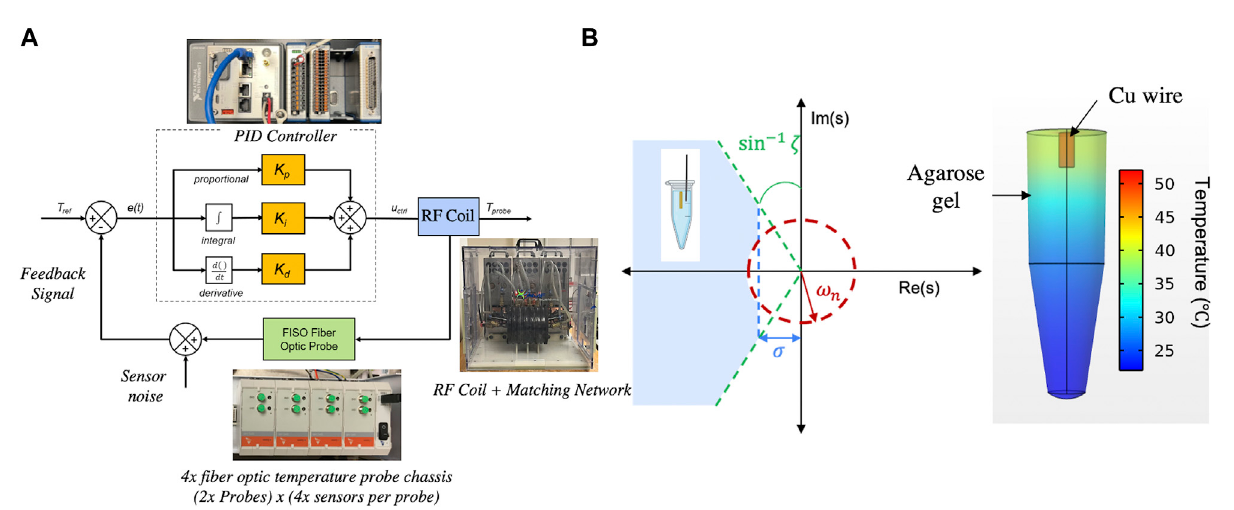
FIGURE 1 (A) Schematic block diagram of the PID controller depicting the error signal ( e(t) ) input and control signal ( u ctrl ) generation to minimize the error e(t) using the PID algorithm. Adapted Jangam et al. (2022), with permission from SB3C Foundation, Inc. Reproduced under CC-BY-4.0, Sharma et al (2023). (B) Regionsinthe s -plane,delineatedbytransientspeci fi cationsoncontrollerdesign,includingrisetime( ω n ,red),overshoot( ζ ,green)andsettlingtime( σ , blue). The agarose gel + Cu wire system (inset schematic) must constitute a transfer function with poles in the shaded region to meet design speci fi cations. The 3D temperature color graph indicates the temperature distribution in the sample after 10 min of AMF treatment at 123 Oe (peak), 160 kHz. Reproduced under CC-BY-4.0, Sharma et al